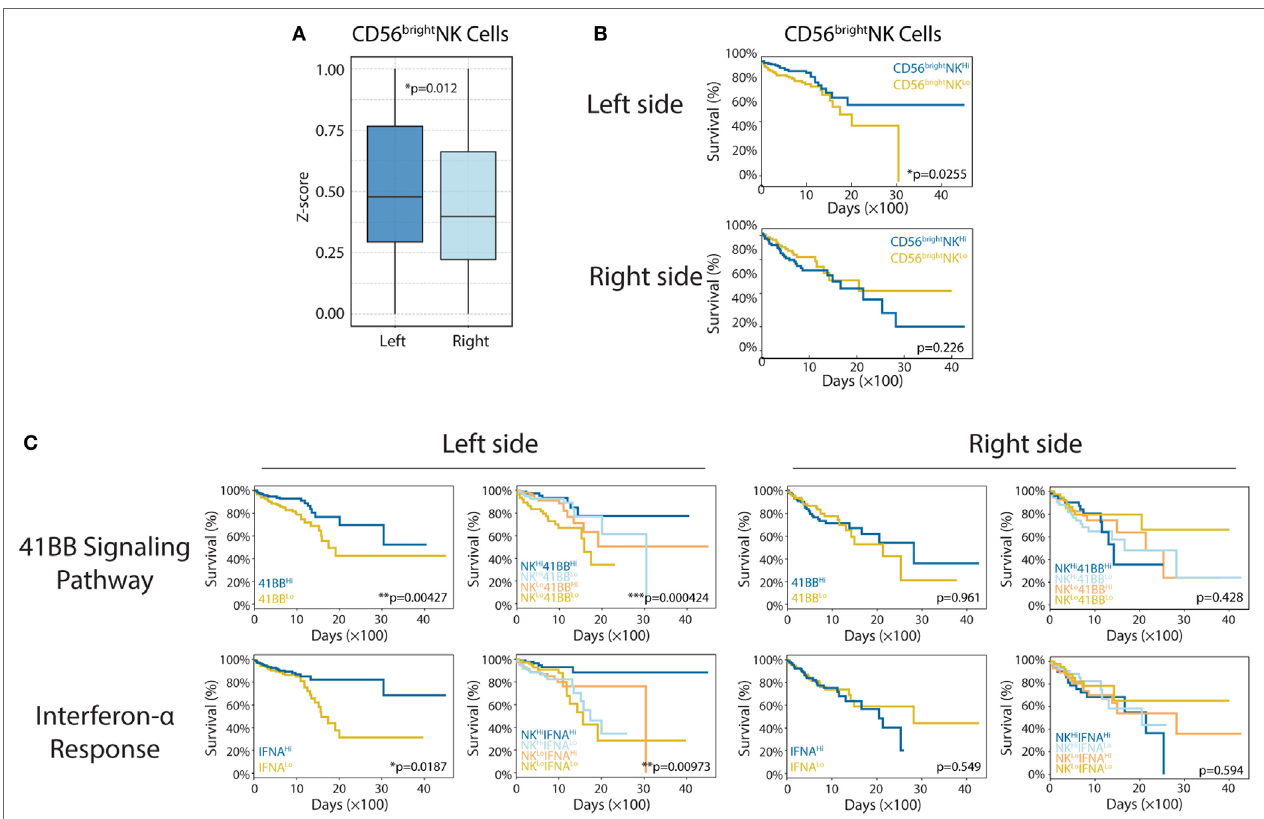
FigUre 3 | Enhanced CD56 bright natural killer (NK) cell response in left-side colorectal cancer (CRC). (a) CD56 bright NK cells in right- and left-side CRC (left vs right,